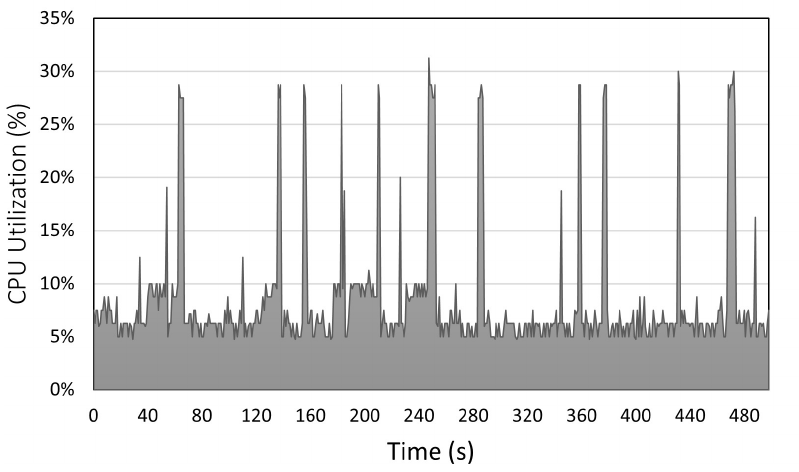
Figure 7. IASE CPU utilization over